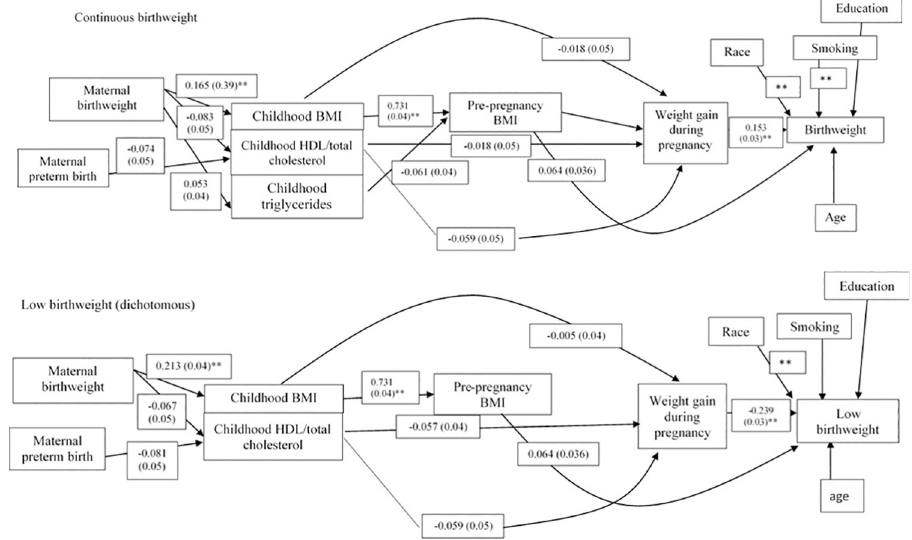
Fig 1. Path model for birthweight. Top panel, continuous birthweight; bottom panel, low birthweight. BMI, body mass index; HDL, high-density lipoprotein. associations that remained in the full model of gestational age (moving left to right in Fig 2, top panel) were: maternal birthweight was associated with childhood BMI, childhood choles- terol was associated with pre-pregnancy cholesterol, and total cholesterol was negatively asso- ciated with gestational age. Weight gain during pregnancy was also associated with gestational age. In the model of preterm birth (moving left to right in Fig 2, bottom panel), maternal birth- weight was associated with childhood BMI and with childhood HDL, maternal preterm birth was associated with childhood LDL. Childhood triglycerides and LD were associated with pre- pregnancy HDL. Childhood HDL and LDL were associated with pre-pregnancy LDL child-